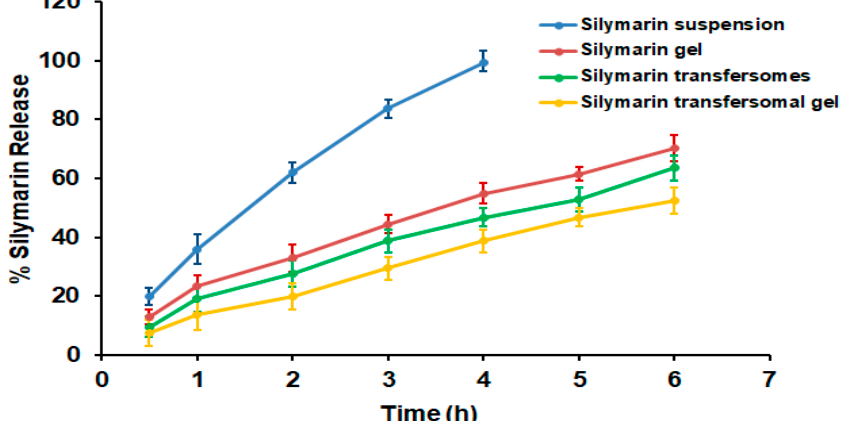
Figure 6. Study of in vitro drug release from different Silymarin formulations and Silymarin sus- pension at 37 °C. Results are stated as the mean ± SD of three